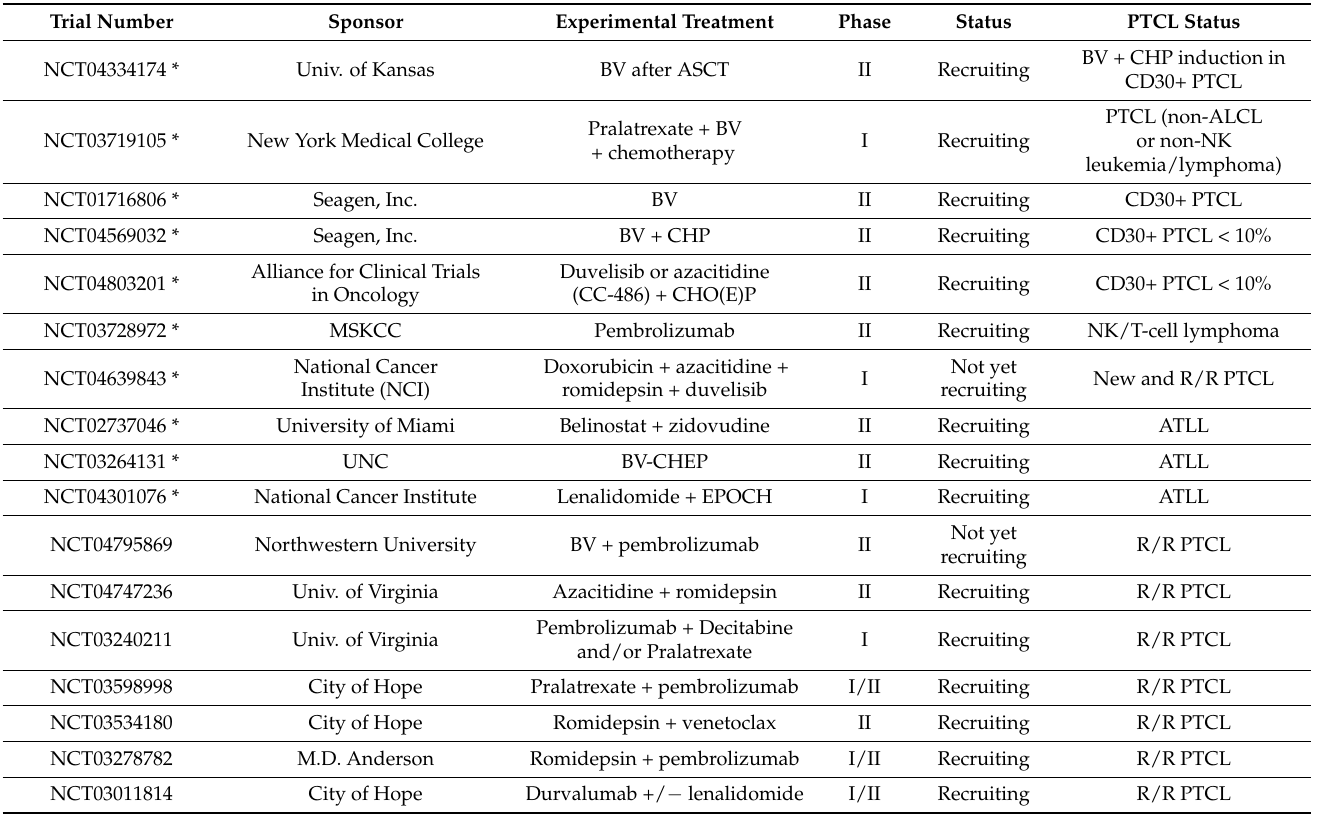
Table 1. Summary of key, actively recruiting, U.S.-based clinical trials for patients with